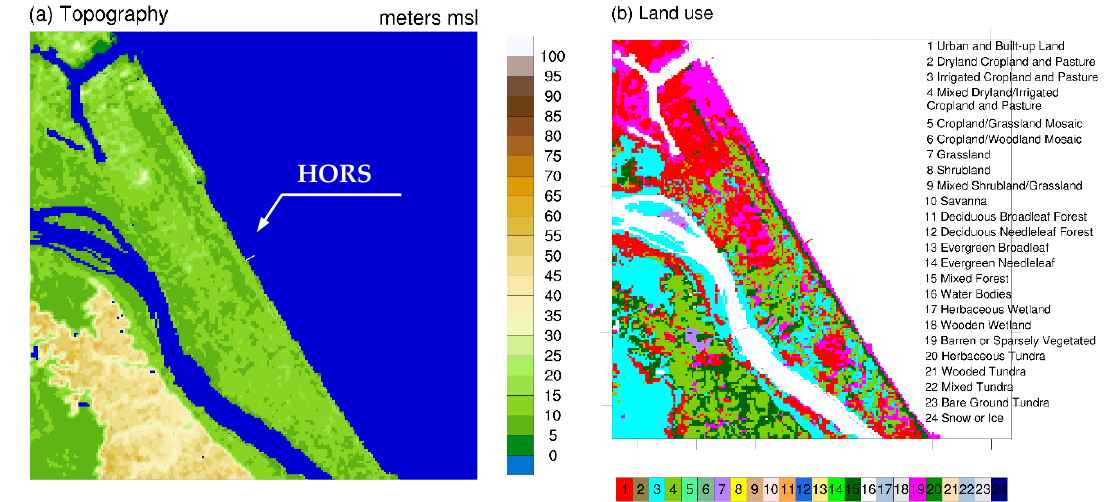
Figure 3. ( a ) Topography and ( b ) land use around the HORS research platform.